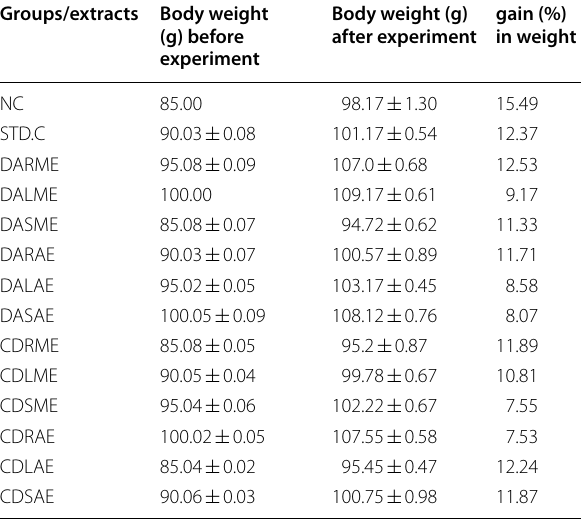
Table 1 Effects of methanol and aqueous extracts of roots, leaves and stem of Chasmanthera dependens and D. arborescens on average body weights of albino rats Groups/extracts Body weight (g)